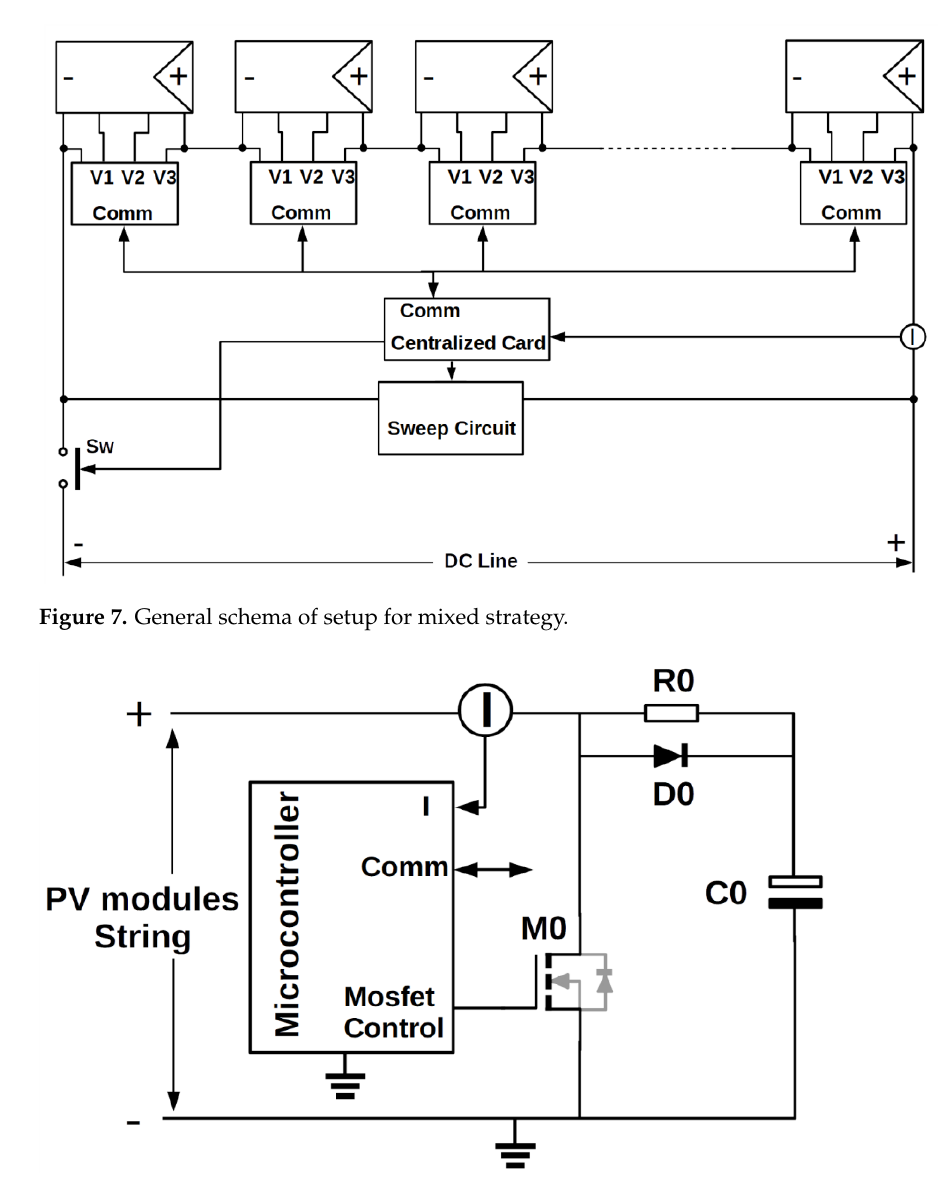
Figure 8. Detail of the centralized card schematic with sweeping circuit on the right.